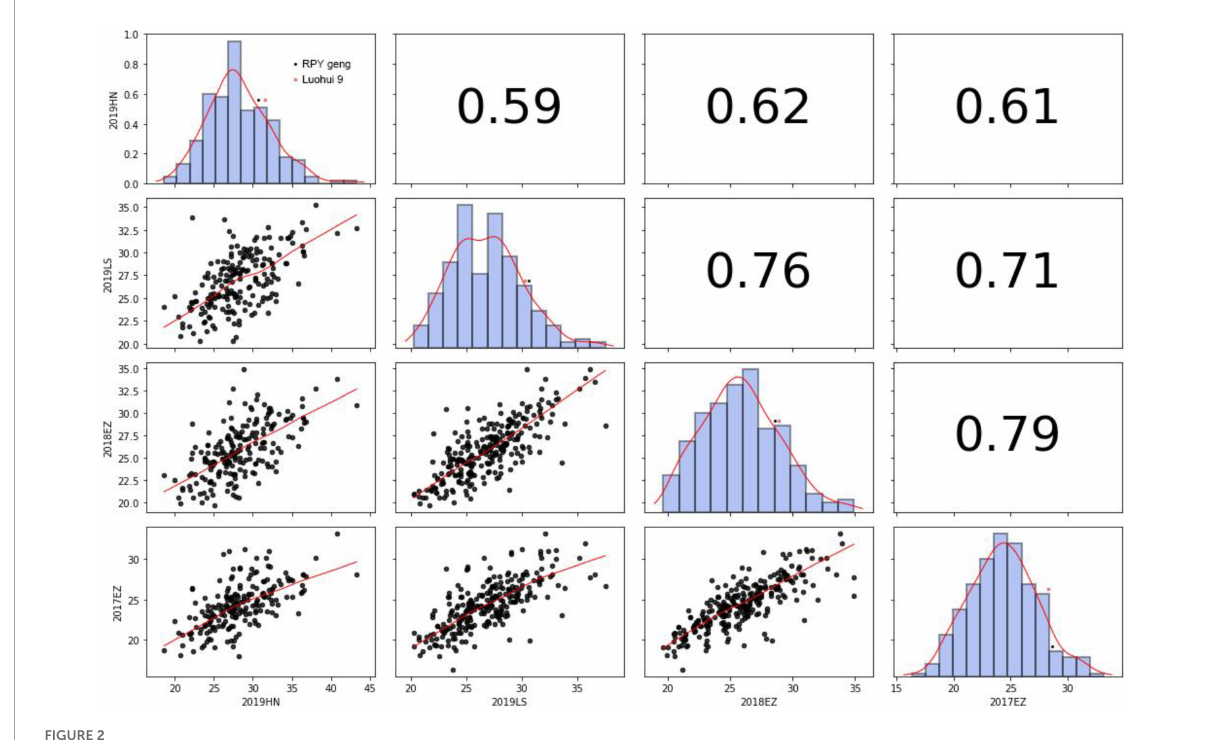
FIGURE2 Thousand-grain weight in 2019HN, 2019LS, 2018EZ and 2017EZ.